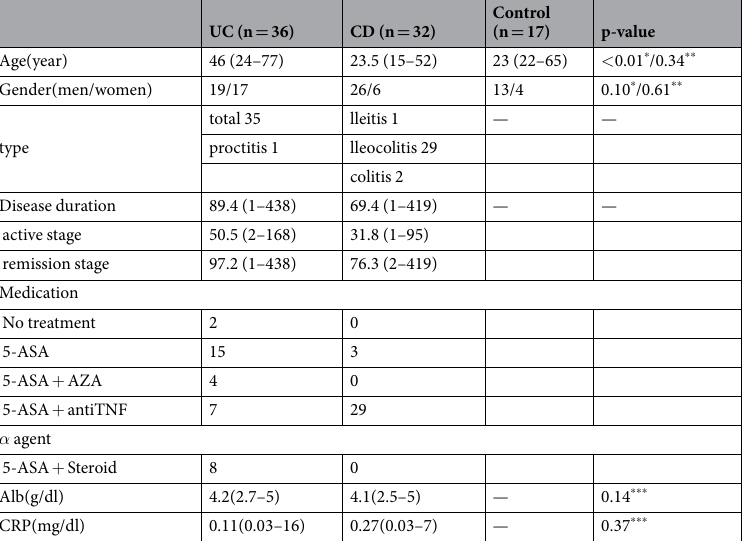
Table 1. Characteristics of the UC, CD, and HC groups. Data are means and medians (interquartile range). Statistical analysis was conducted using the Mann-Whitney U test. * Control vs. UC. ** Control vs. CD. *** UC vs. CD 5-ASA, 5-aminosalicylic acid; AZA, azathioprine; Anti-TNF- α agent, anti-tumor necrosis factor- α agent. Alb, Albumin; CRP, C-reactive